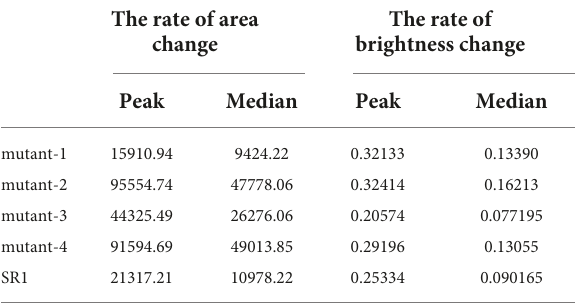
TABLE 3 The peak and median of the rate of green fluorescence area and brightness change per